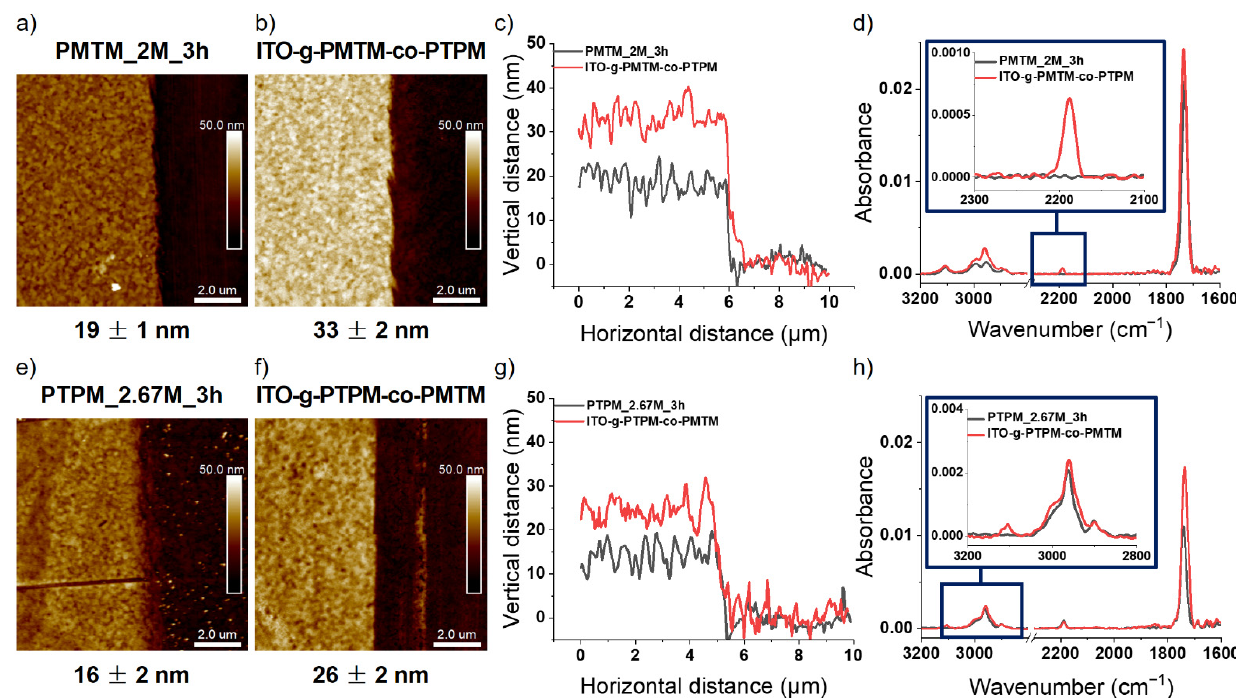
Figure 8. AFM images and cross-section profiles of: PMTM_2M_3h ( a , c ), ITO-g-PMTM-co-PTPM ( b , c ), PTPM_2.67M_3h ( e , g ), and ITO-g-PTPM-co-PMTM brushes ( f , g ). FTIR spectra of: ( d ) PMTM_2M_3h and ITO-g-PMTM-co-PTPM brushes, as well as ( h ) PTPM_2.67M_3h and ITO-g-PTPM-co-PMTM brushes.